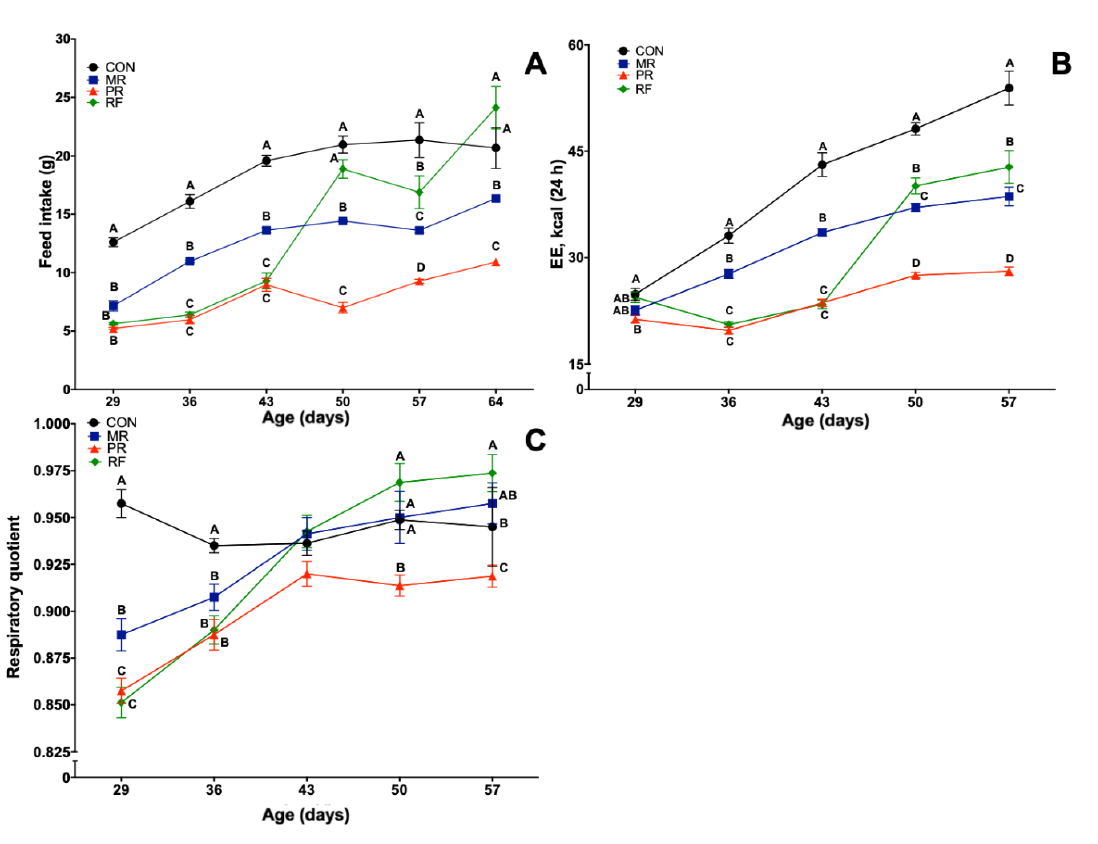
Figure 1. Mean (± SEM) effects of feed restriction and refeeding in rats on: feed intake ( A ); energy expenditure ( B ); and respiratory quotient ( C ) (n = 8 / group). CON (Control), ad libitum feeding; MR (Mild Restriction), 75% of CON intake; PR (Profound Restriction), 50% of CON intake; and RF (Refeeding group), 50% of CON intake for 14 days, and then ad libitum. Treatment, time and treatment by time interaction were significant ( p < 0.05) for all three end points. A–D Within a day of age, means without a common superscript differed ( p < 0.05).